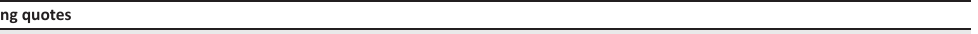
TABLE 1: Themes that emerged from the qualitative